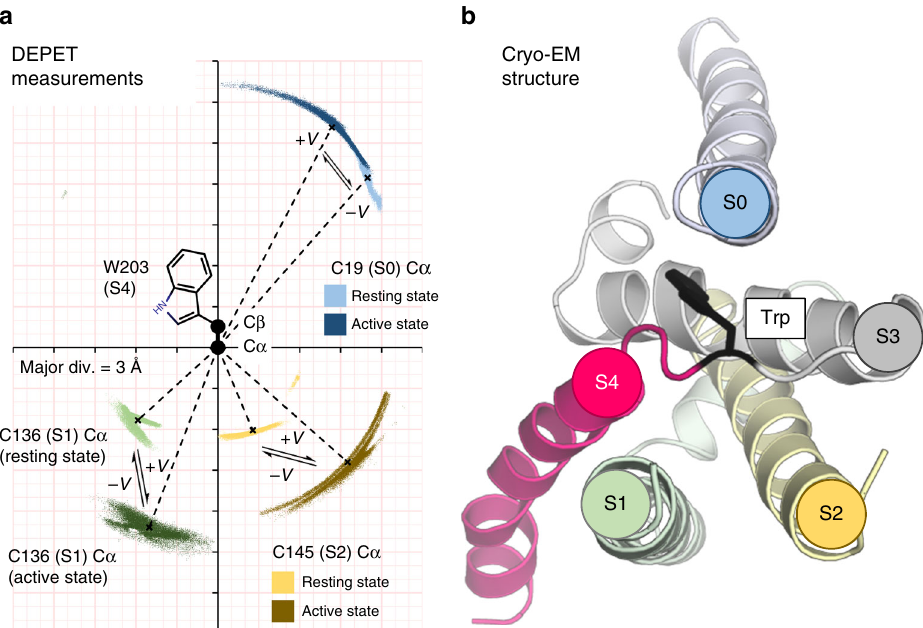
Fig. 5 DEPET results in relation to the known structure of the BK VSD. a Distribution of the labeled Cys C α atoms in the resting (position 19, S0: light blue; position 136, S1: light green; position 145, S2: yellow) and active (19: dark blue; 136: dark green; 145: dark yellow) conformations with respect to the 203 Trp C α and C β atoms, calculated by the DEPET distance measurements (Fig. 4). The dashed lines indicate the mean d αα distances in the resting and active states (Fig. 4b, e, h). The angle formed by the 19 Cys C α – 203 Trp C α – 203 Trp C β atoms was 41° [37°,48°] in the resting conformation and 28° [10°,38°] in the active conformation. The orientation of 203 Trp side-chain with respect to 136 Cys in S1 was determined to be 132° [123°,142°] in the resting conformation and 159° [148°,172°] in the active conformation. Finally, the orientation of 203 Trp with respect to 145 Cys in S2 was 157° [115°,175°] in the Resting state and 132° [108°,157°] in the Active state. That is, the side-chain of W203 (helix S4) points towards helix S0 and away from helices S1 and S2, and its distance increases upon voltage-dependent activation. b Top view of an isolated voltage-sensing domain from the cryo-EM-derived structure of the Aplysia ligand- free/shut BK channel (PDB: #5TJI 21 ). W192 (homologous to W203 in the human channel 20 ) is shown with its side-chain, in